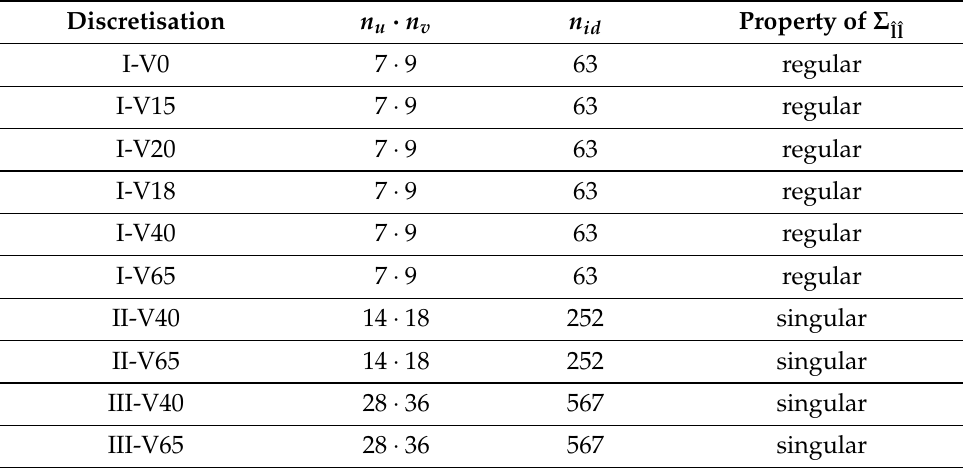
Table 1. Overview of the discretisations [30].